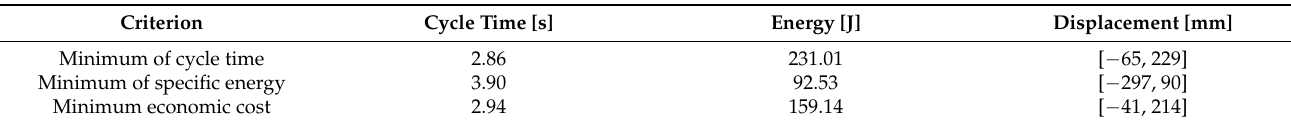
Table 8. Results of optimisation tasks.